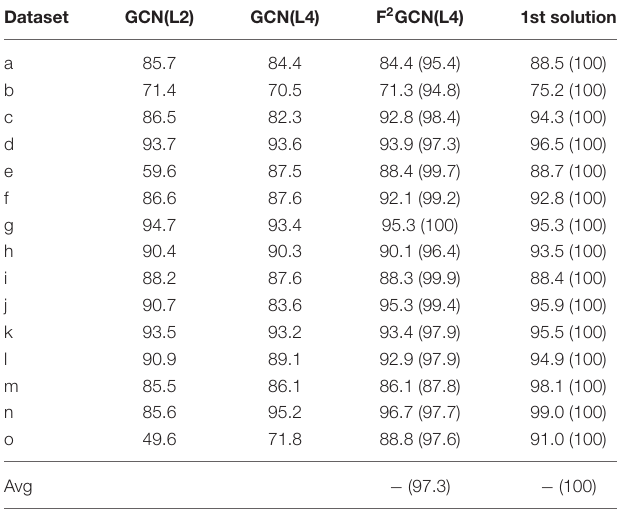
TABLE 4 | Accuracy comparison of GCN baselines, F 2 GCN, and industrial best solution (%). Dataset